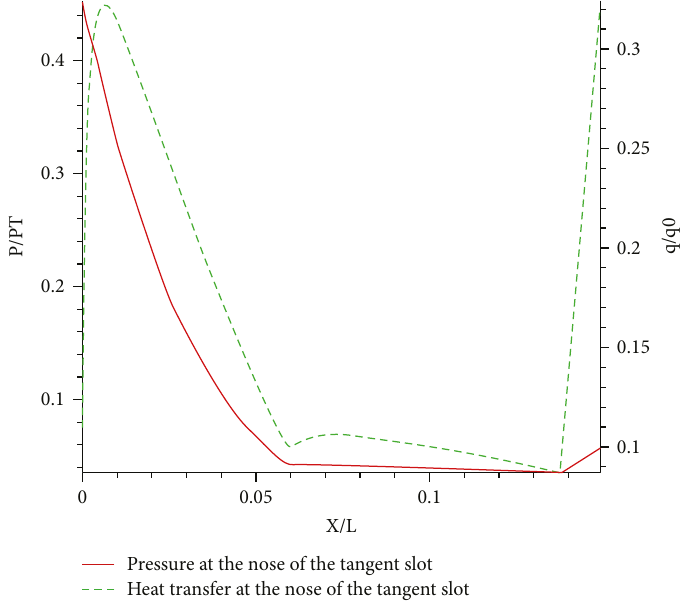
Figure 27: Pressure and heat transfer rates near the tangent-slot